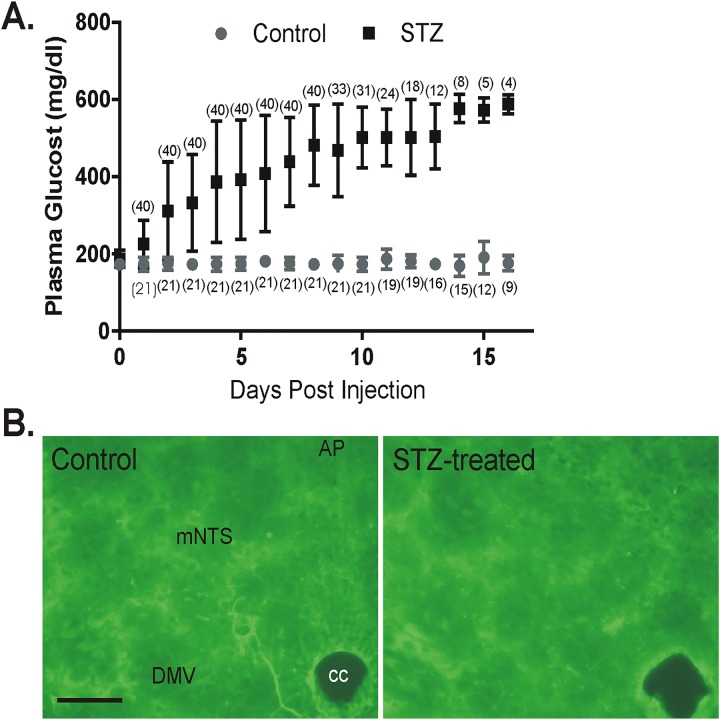
Effects of streptozotocin (STZ) injection on the time course of plasma glucose concentration and Fluoro-Jade B staining in the dorsal vagal complex.
A. Time course of plasma glucose concentration (± standard deviation) in control and STZ-treated mice. Numbers in parenthesis indicate the number of mice maintained up to each day post injection. B. Fluoro-Jade B staining in the dorsal vagal complex 24 h after intraperitoneal injection of saline (left) or STZ (200 mg/kg; right). Cellular Fluoro-Jade labeling, an indicator of necrotic cell death, was not observed in the vagal complex after peripheral STZ injection. AP, area postrema; NTS, nucleus tractus solitarius; DMV, dorsal motor nucleus of the vagus; cc, central canal; scale bar = 100 μm.